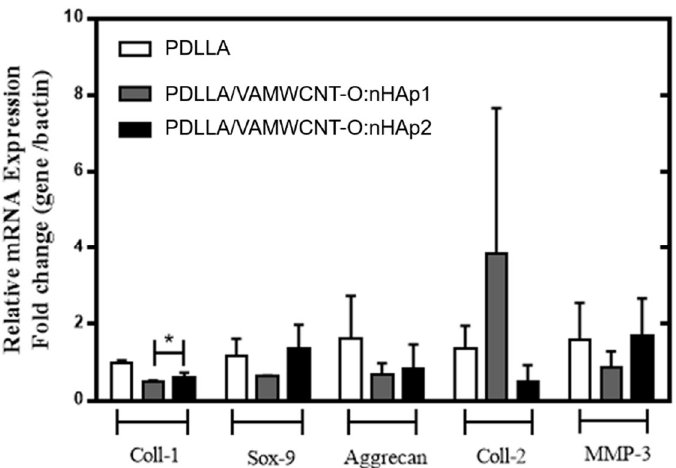
Figure 5. Gene expression of human chondrocytes on PDLLA, PDLLA/VAMWCNT-O:nHAp1, and PDLLA/VAMWCNT-O:nHAp2 membranes after five days in culture. The bar graphs show relative gene expression levels after normalization to beta-actin.